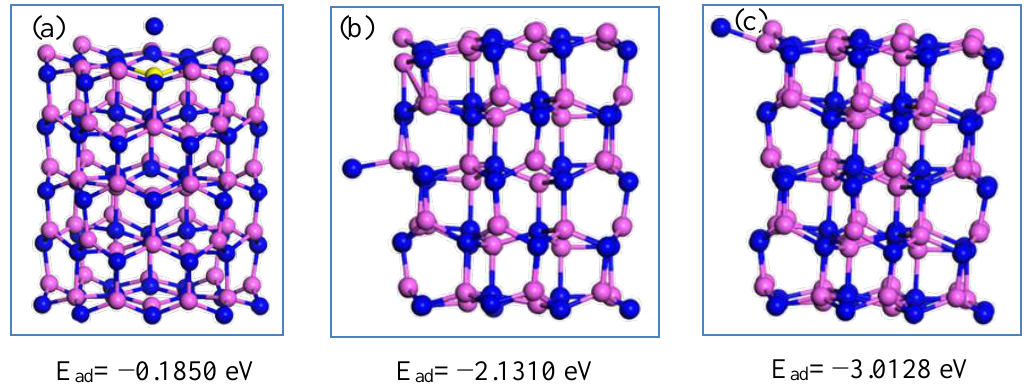
Figure 5. The chemisorption of N element at different sites of the Al 60 N 60 cluster. The Al and N atoms are shown in pink and blue. The N atom is located at the top, side and edge position of the Al 60 N 60 cluster shown in a , b and c , respectively.